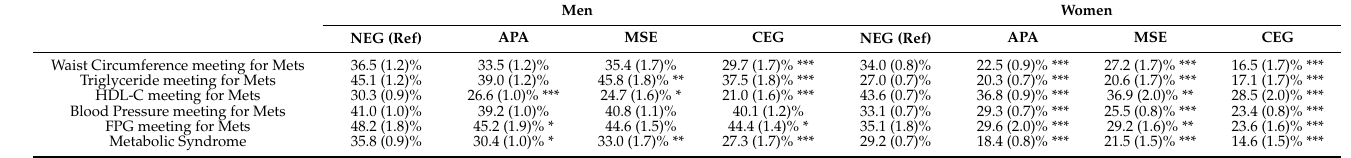
Table 3. The prevalence of metabolic syndrome and its components according to exercise